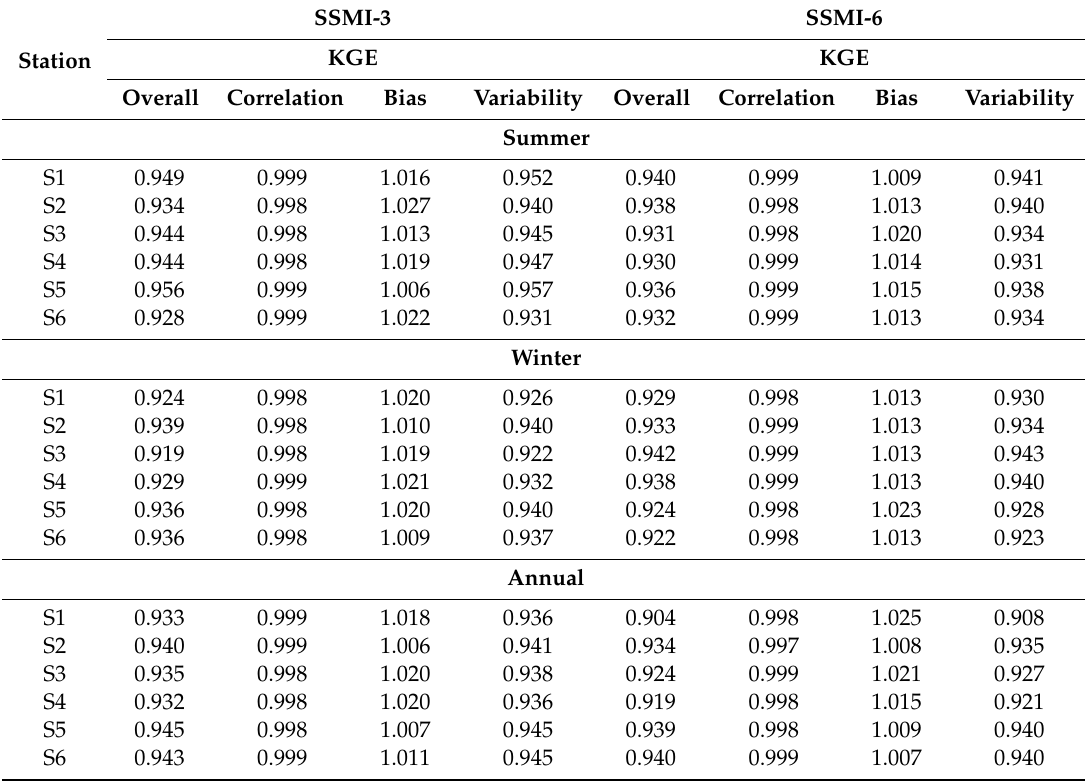
Table 2. Goodness of fit statistics for the agricultural drought indicator (SSMI) at six representative stations across climate zones (see Figure 2b for the locations of stations and corresponding climate zones). SSMI-3 SSMI-6 Station Correlation Bias Variability Overall Correlation Bias